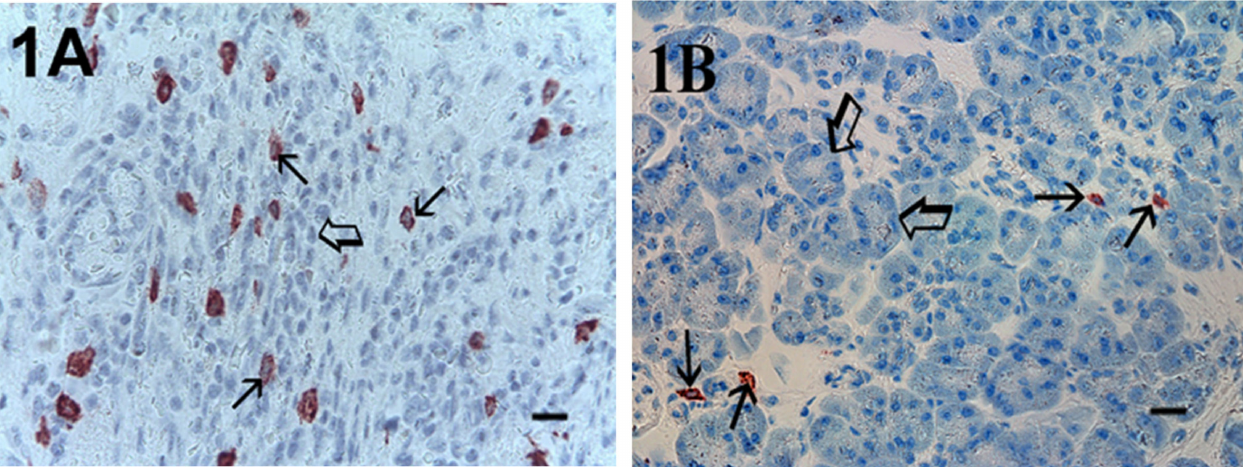
Figure 1. Magnification × 400, 0.19 mm 2 area, immunostaining with the anti-CD117 antibody. ( A ) High MCDP-c-KitR in primary PDAT section. Small arrows indicate single red-stained MCs. The big arrow indicates tumour epithelium. ( B ) Low MCDP-c-KitR in ANT section. Small arrows indicate single red-stained MCs. Big arrows indicate normal pancreatic epithelium. Scale bar corresponds to 125 µ m. MCDP-c-KitR, density of mast cells positive for c-Kit receptor; PDAT, pancreatic ductal adenocarcinoma tissue; MCs, mast cells; ANT, adjacent normal